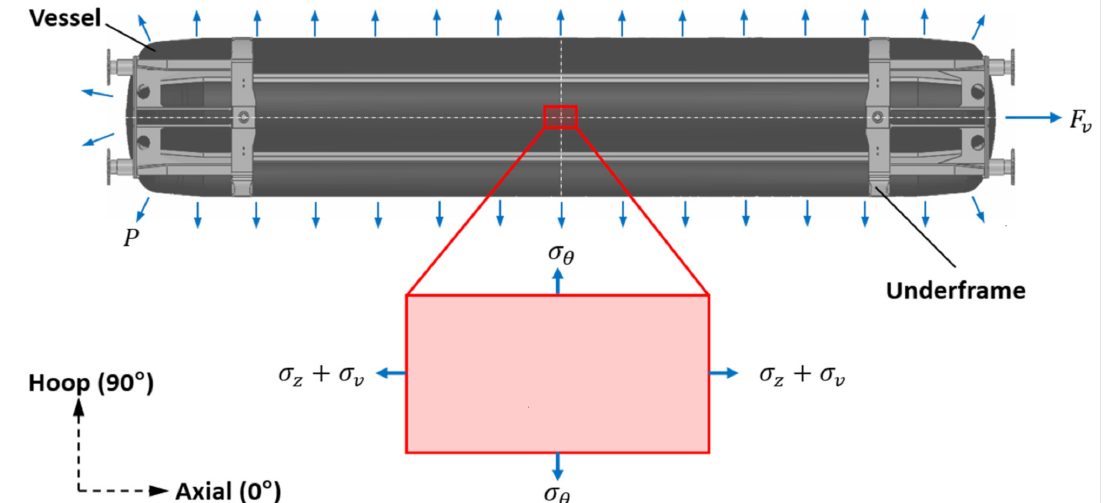
Figure 4. The underside of a composite tank wagon and the associated forces acting on an extracted specimen from the centreline of the vessel. The bogie wheelsets have been removed from the figure to aid